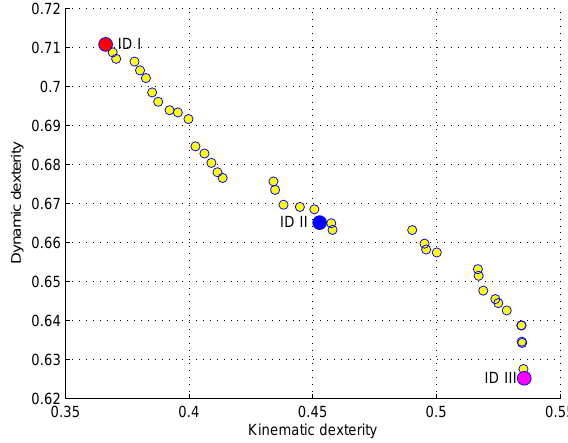
Figure 7: The Pareto front of the multiobjective opti- mization problem for the